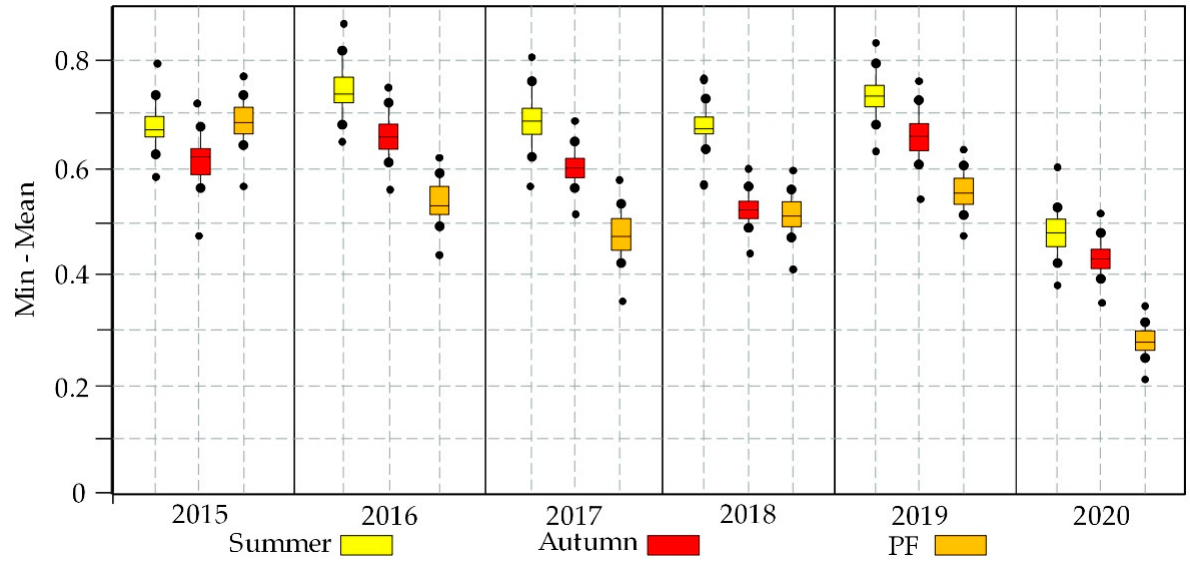
Figure 6. Results of fire severity levels using NBR.